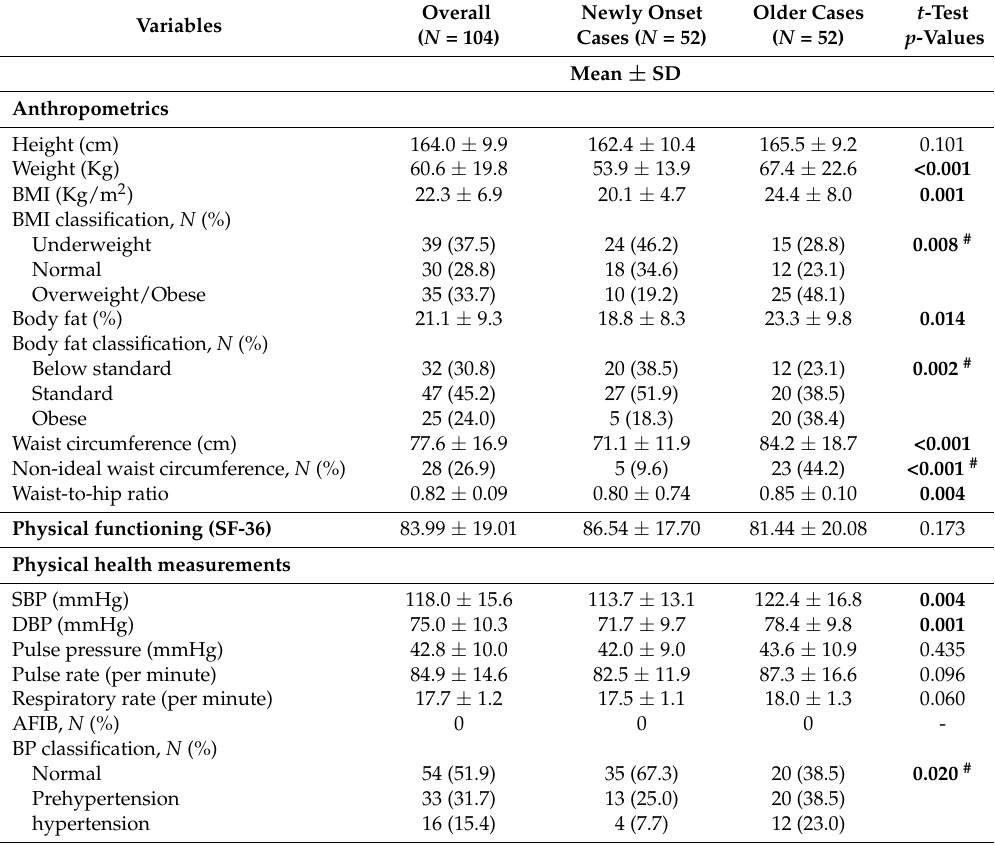
Table 3. A summary of anthropometric, physical functioning and physical health in hikikomori. Overall Variables ( N =